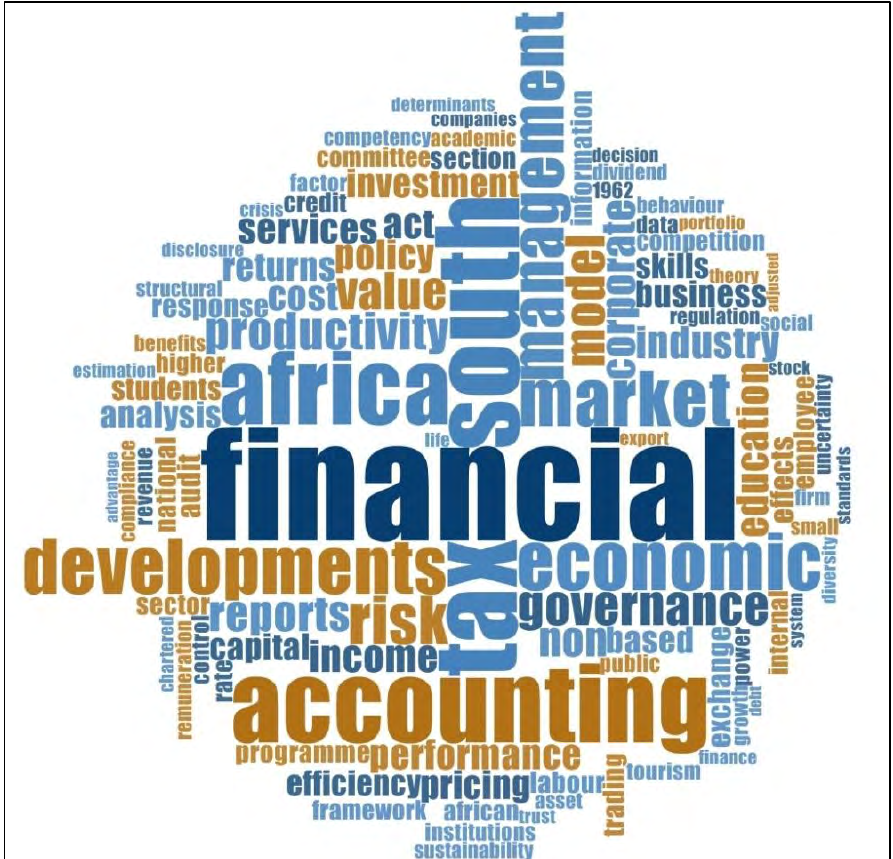
FIGURE 3: Word frequency cloud (Keywords) Source: